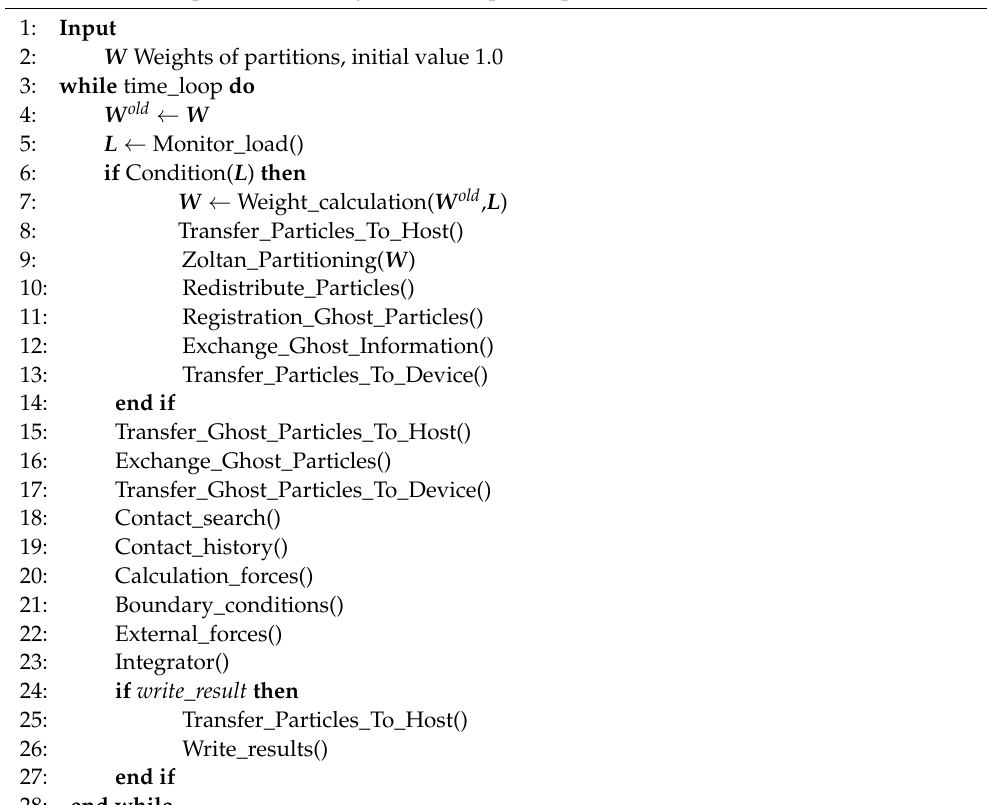
Algorithm 1 The pseudocode of hybrid MPI/OpenCL